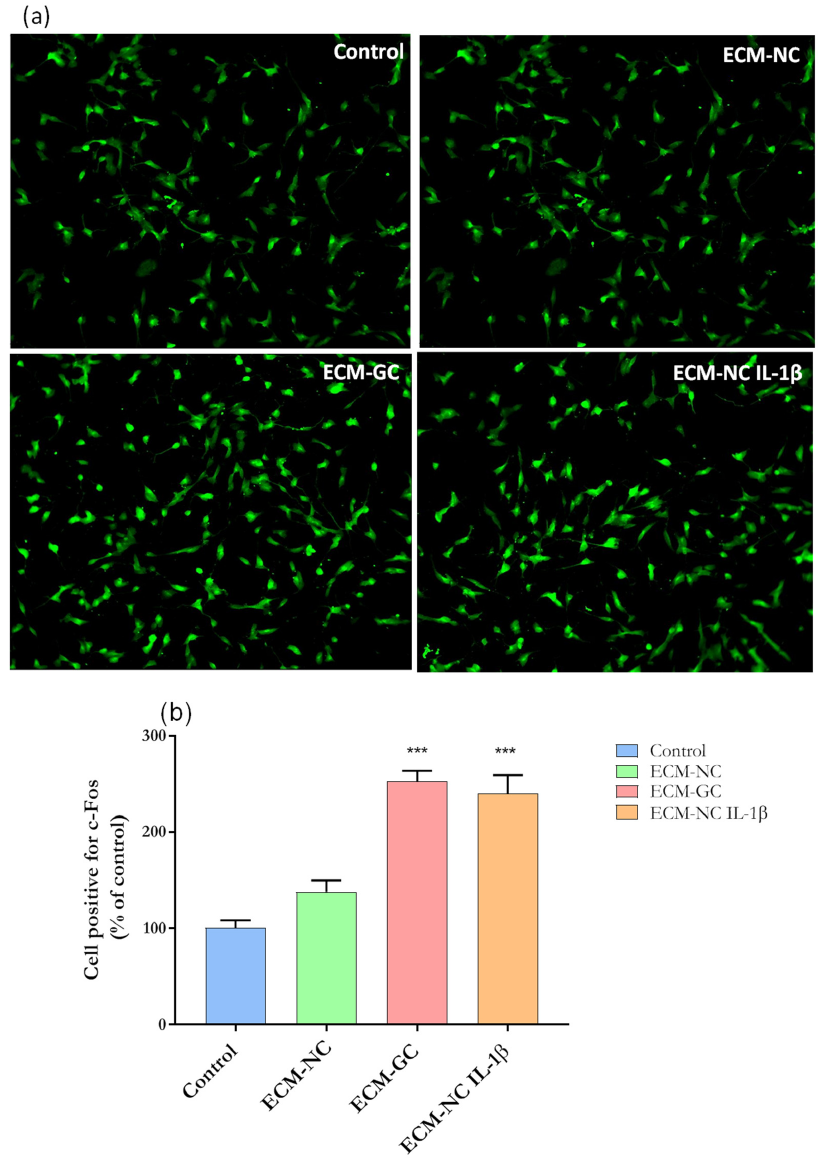
Figure 8. Representative images of immunofluorescence of c-Fos expression. ( a ) c-Fos expression in sensory neuron-like cells incubated with ECM-NC, ECM-GC, ECM-NC IL-1 β or medium culture for 1 h. Magnification: 20×. ( b ) Quantification of c-Fos nuclear expression (% of control). Data were analyzed by one-way ANOVA with post hoc testing by Dunnett (*** p < 0.0001 different from Control). NC (normal collagen), and GC (glycated collagen). Three independent and similar assays were performed in triplicate. Nav 1.7 and NK1 receptors ligand are involved in the induction and maintenance of pain state. The results presented in Figure 9a show that ECM-GC and IL-1 β significantly